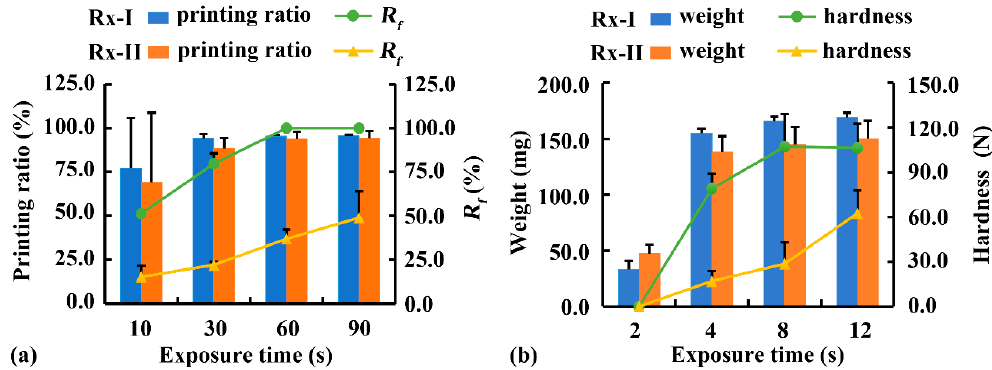
Figure 8. Effect of exposure time of ( a ) bottom three layers and ( b ) other layers on printability. Rx-I: 100% PEGDA; Rx-II: 75% PEGDA with 0.25 mg/mL tartrazine; R f : cavity fusion